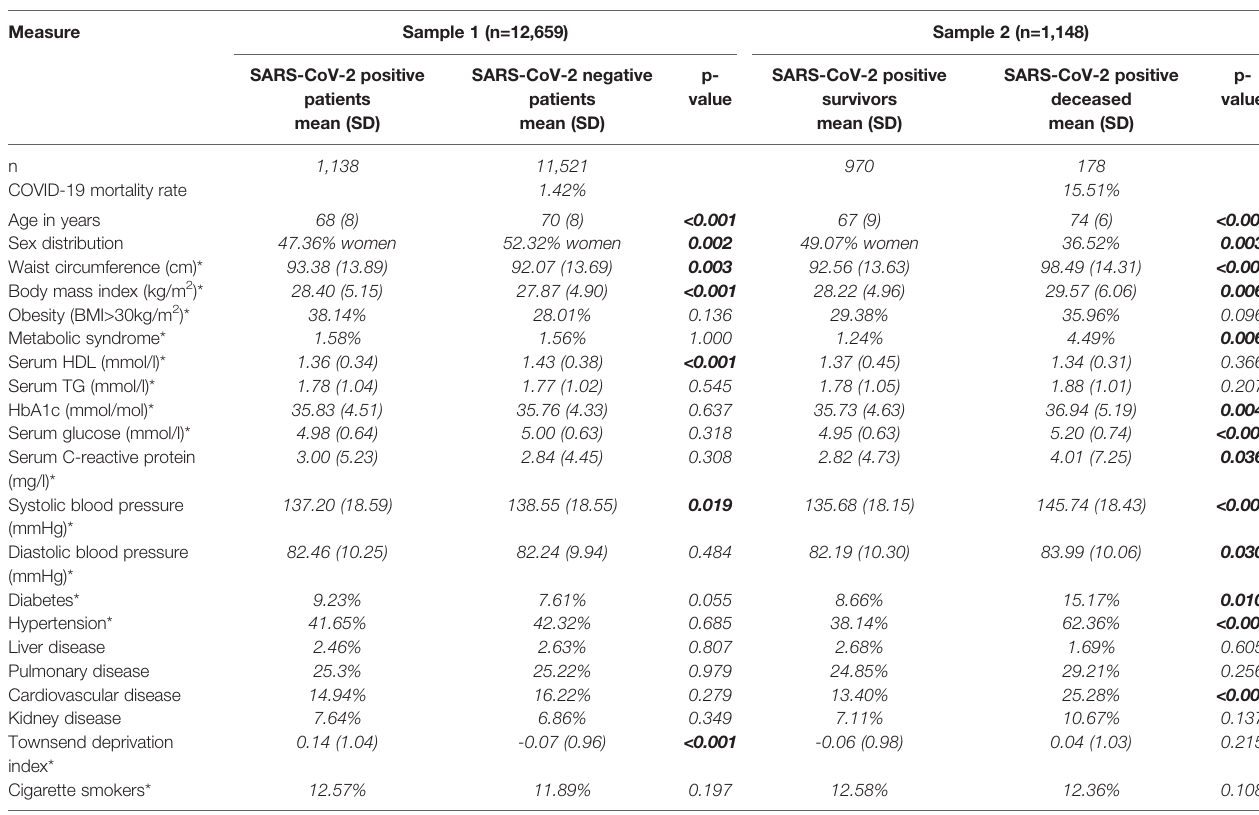
TABLE 1 | Participants